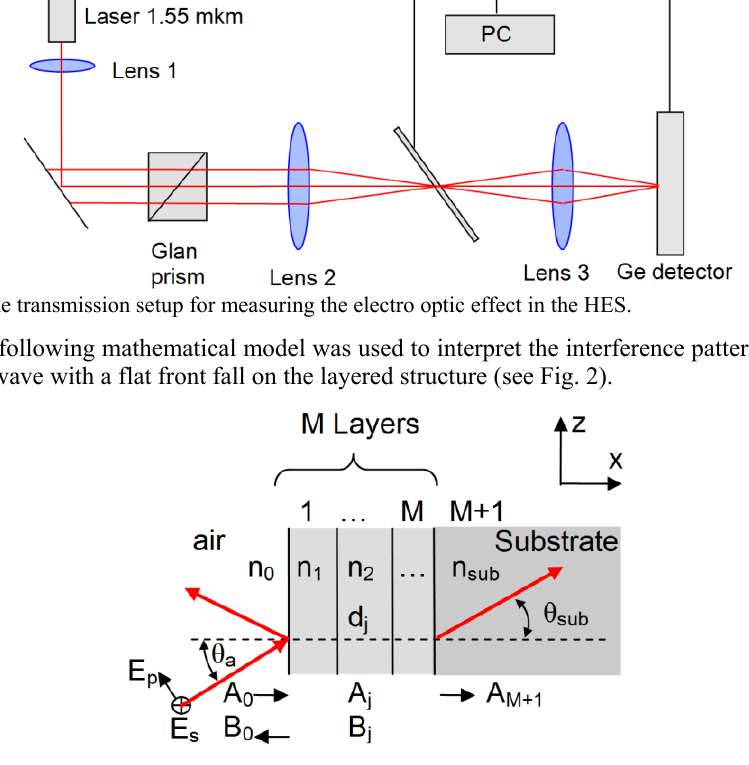
Fig. 2. Light incident with p (TM) or s (TE) polarization on a layered structure with the M layers {dj,